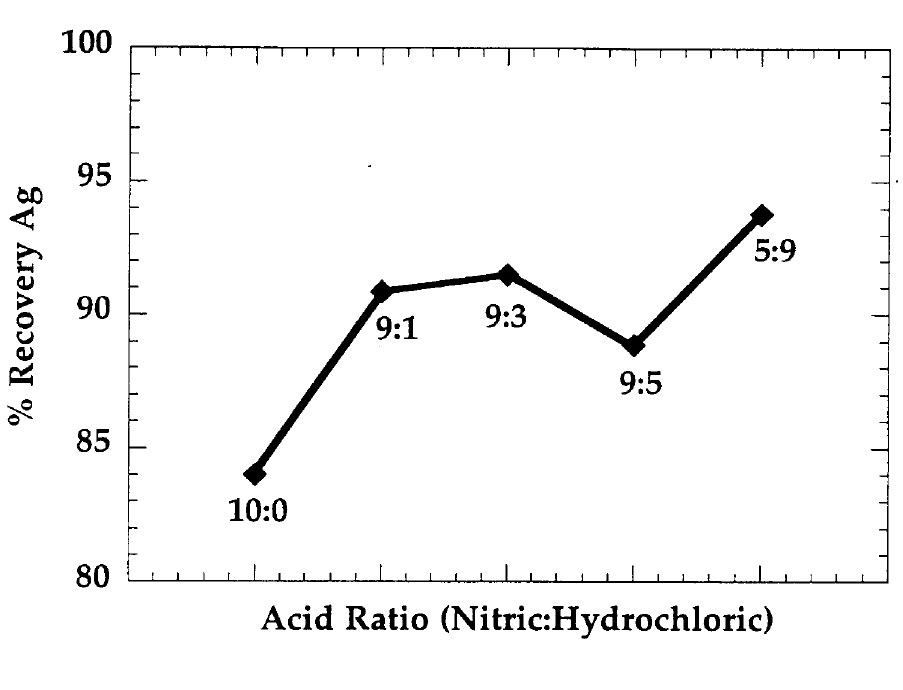
Figure taken from Refs. 6 and